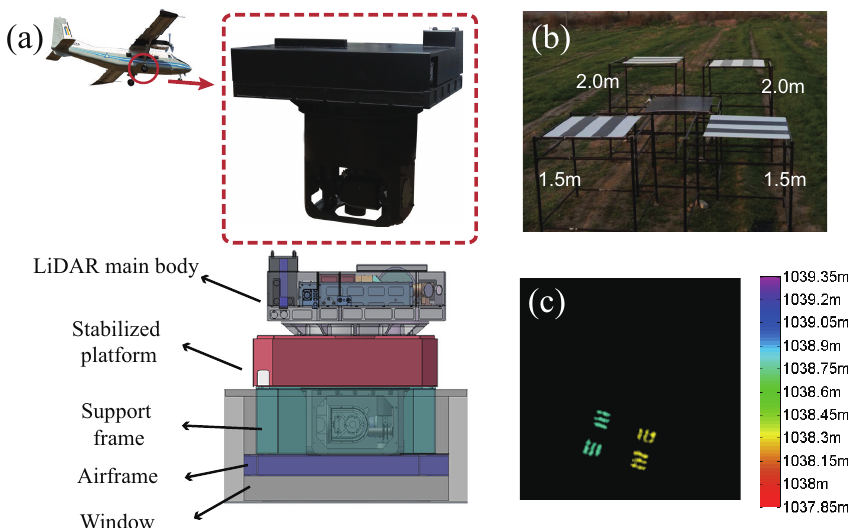
Figure 2. The result of the 3D GISC LiDAR reconstruction, the color bar denotes the distance to the GISC LiDAR: ( a ) the airborne 3D GISC LiDAR system, ( b ) a photo of the target, ( c ) the structured 3D GISC reconstruction